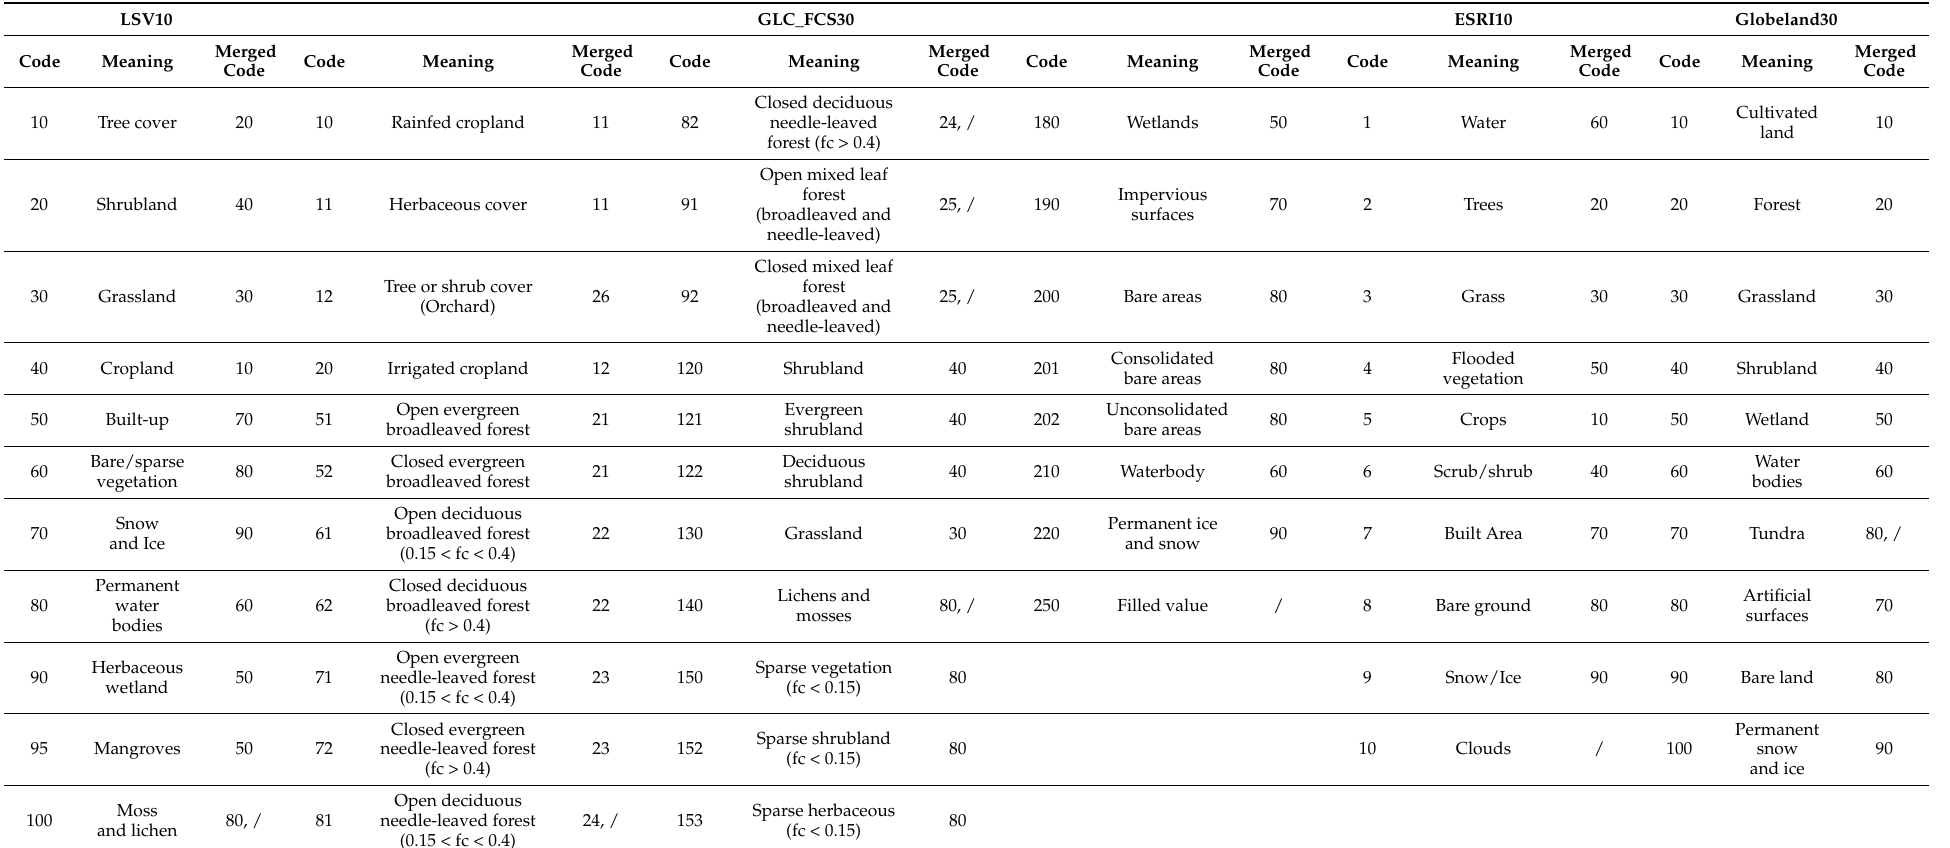
Table 2. LUC codes and meanings of the source datasets and merged